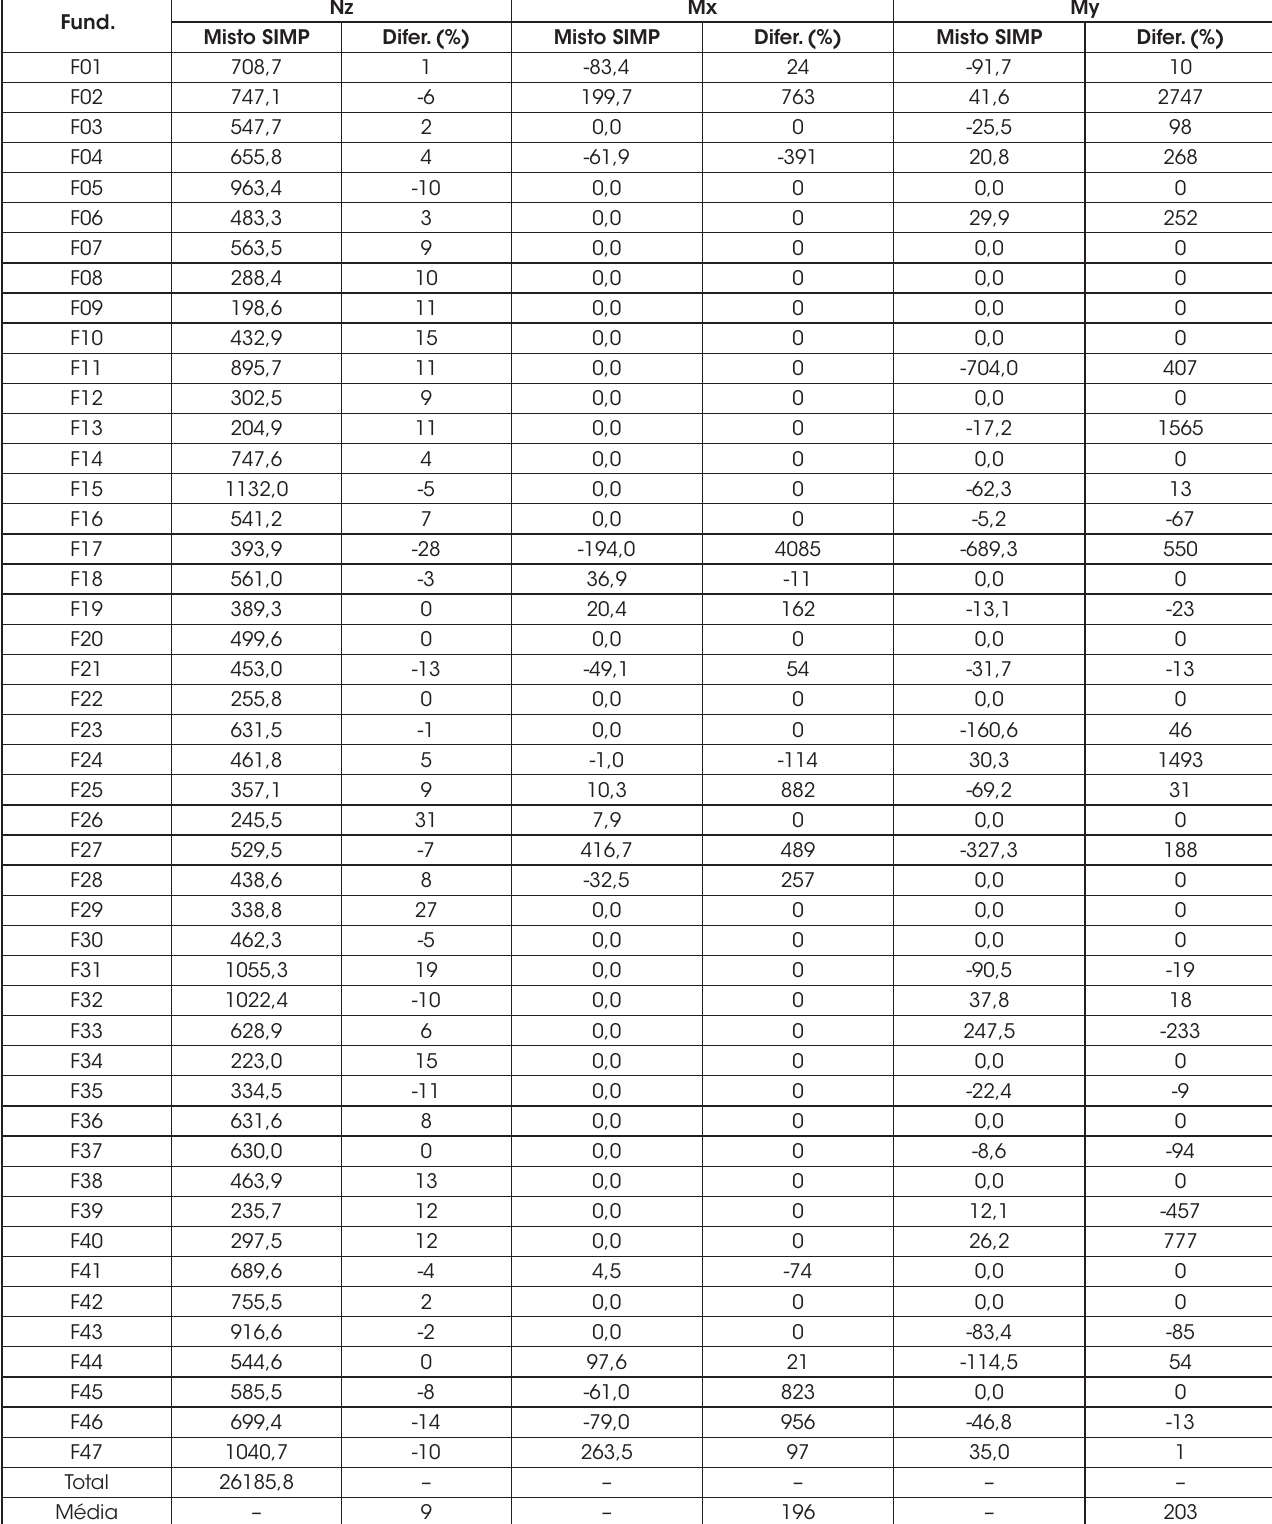
Carregamento nas fundações modelo misto SIMP – kN e kN.m